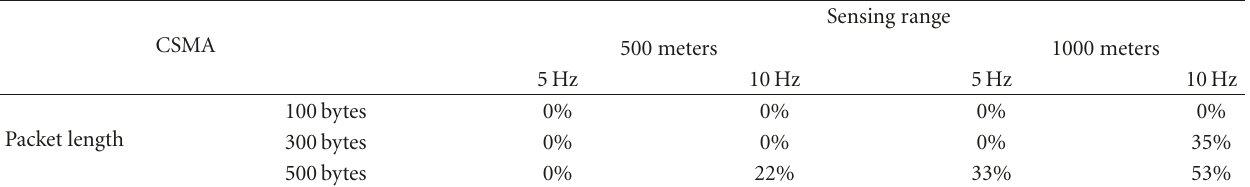
Table 5: The intentional reuse of slots within sensing range for di ff erent data tra ffi c scenarios in the STDMA case. STDMA